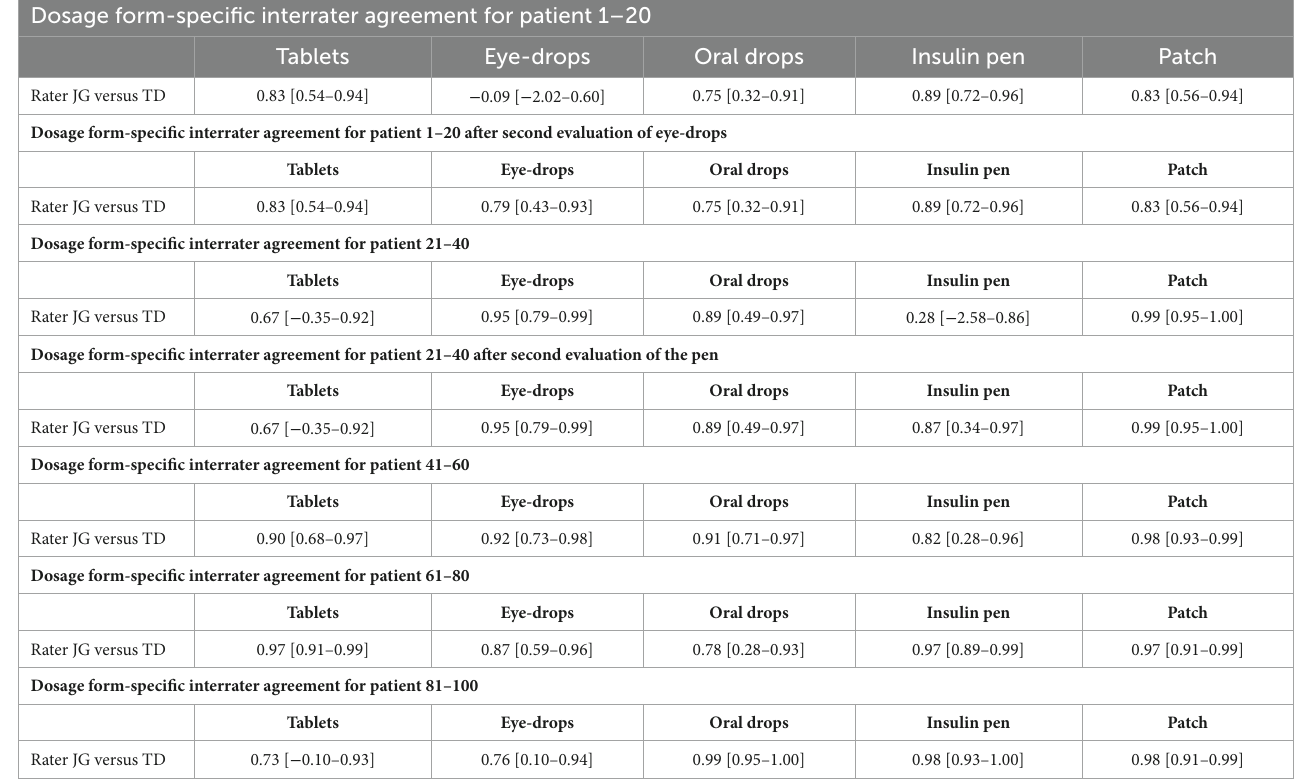
TABLE 3 Dosage form-specific rating results: ICC with 95% confidence intervals. Dosage form-specific interrater agreement for patient 1–20